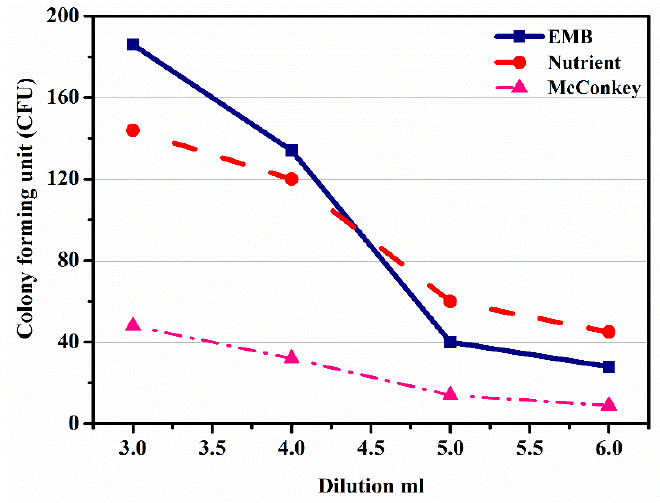
Figure 5. Effect of dilution on colony-forming unit in eosin methylene blue agar, nutrient agar, and McConkey agar. Table 3. Values of colony-forming units as per dilutions in eosin methylene blue agar, nutrient agar, and MacConkey agar.